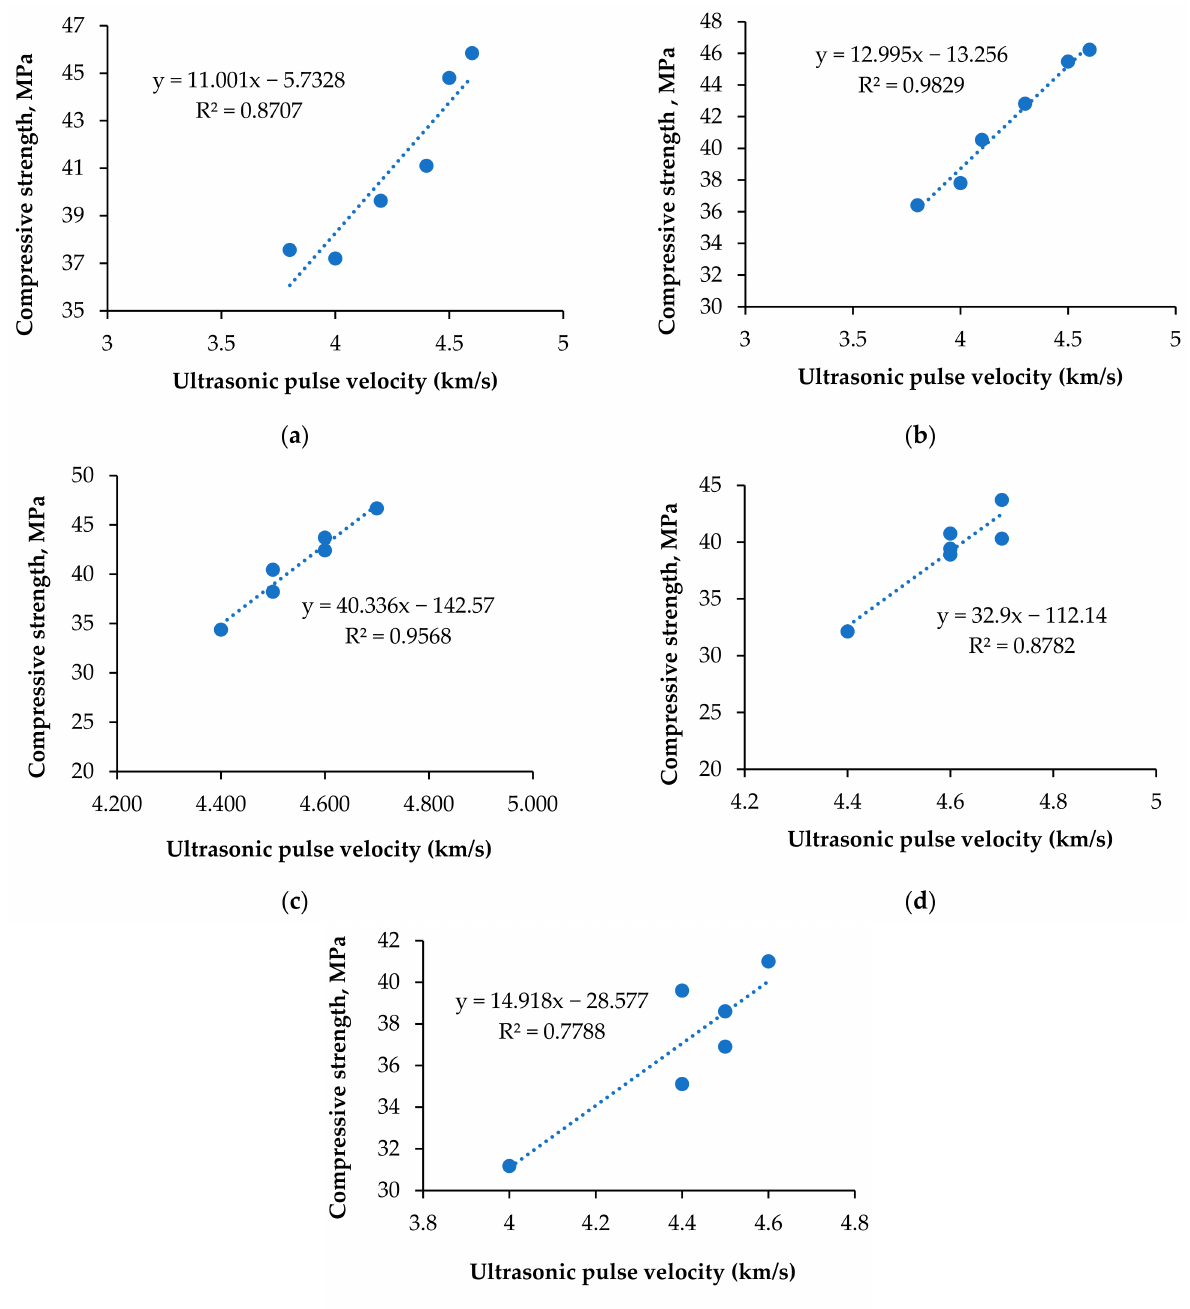
Figure 12. Relationship between UPV and compressive strength for CS40 group. ( a ) 0% PPF; ( b ) 0.2%PPF; ( c ) 0.4%PPF; ( d ) 0.6%PPF; ( e )